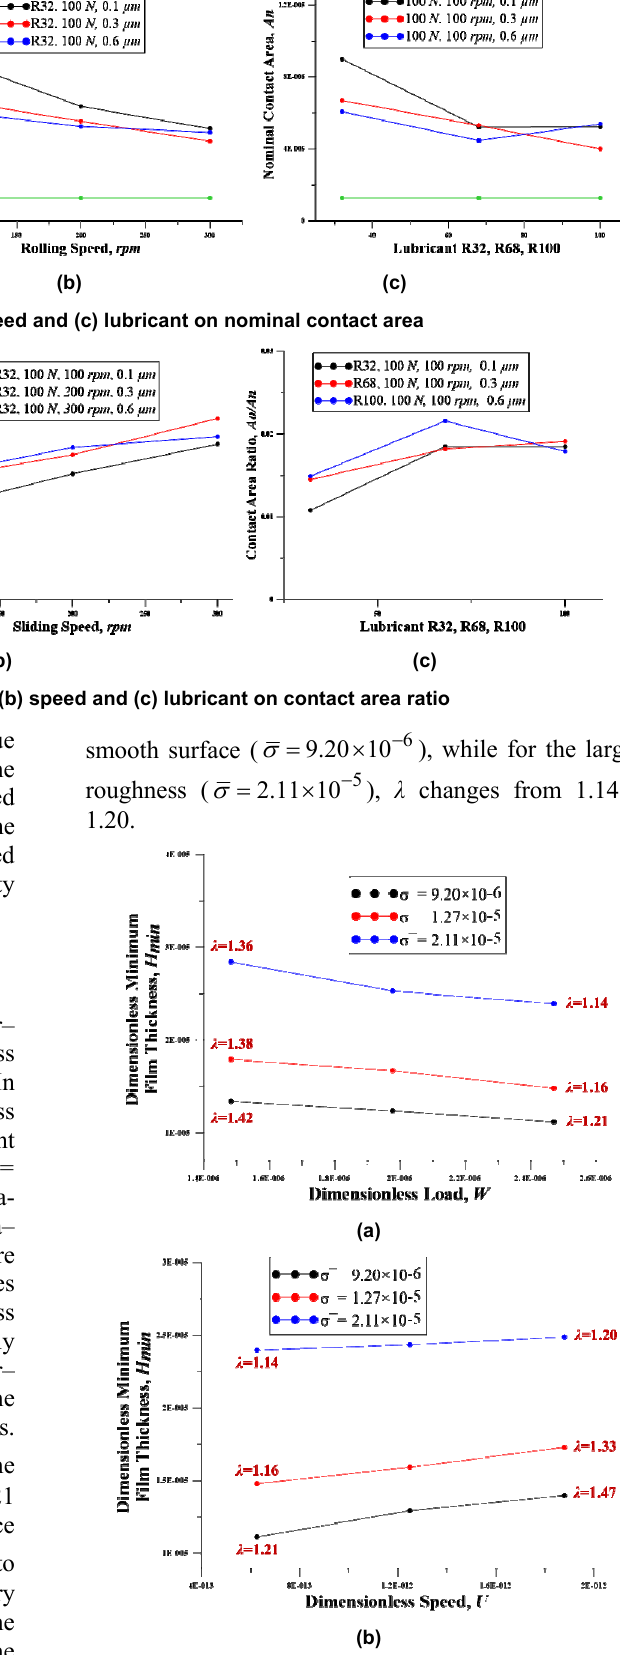
Figure 10. Effect of (a) load (b) speed and (c) lubricant on nominal contact area